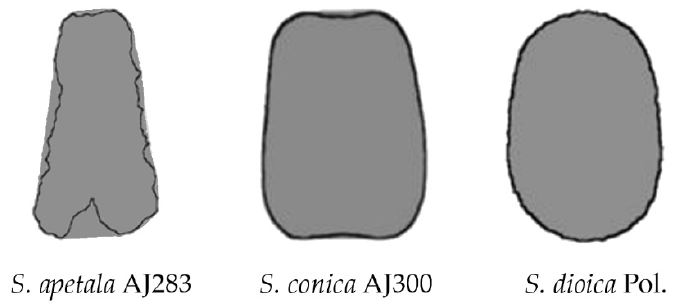
Figure 12. Average silhouettes for the dorsal views of 20 seeds of S. apetala AJ283, S. conica AJ300, and S. dioica Pol. with the corresponding convex hull superimposed. Table 1. Values of solidity and perimeter ratio (perimeter of the convex hull/ perimeter of the image) in three seeds for the dorsal views of the seed images of S. apetala AJ283, S. conica AJ300, and S. dioica Pol. Values marked with the same superscript letter in each column correspond to populations that do not differ significantly at p < 0.05 (Campbell and Skillings’s test). N indicates the number of seeds analyzed.